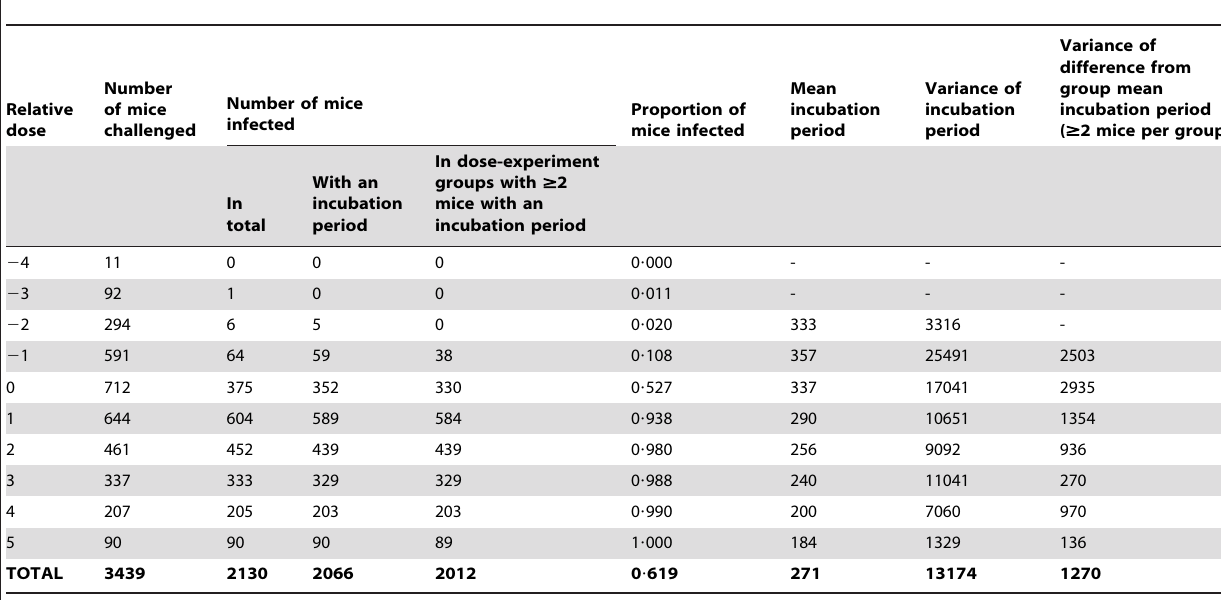
Table 1. Proportion of mice infected, mean incubation period and variance of incubation period at each relative dose.